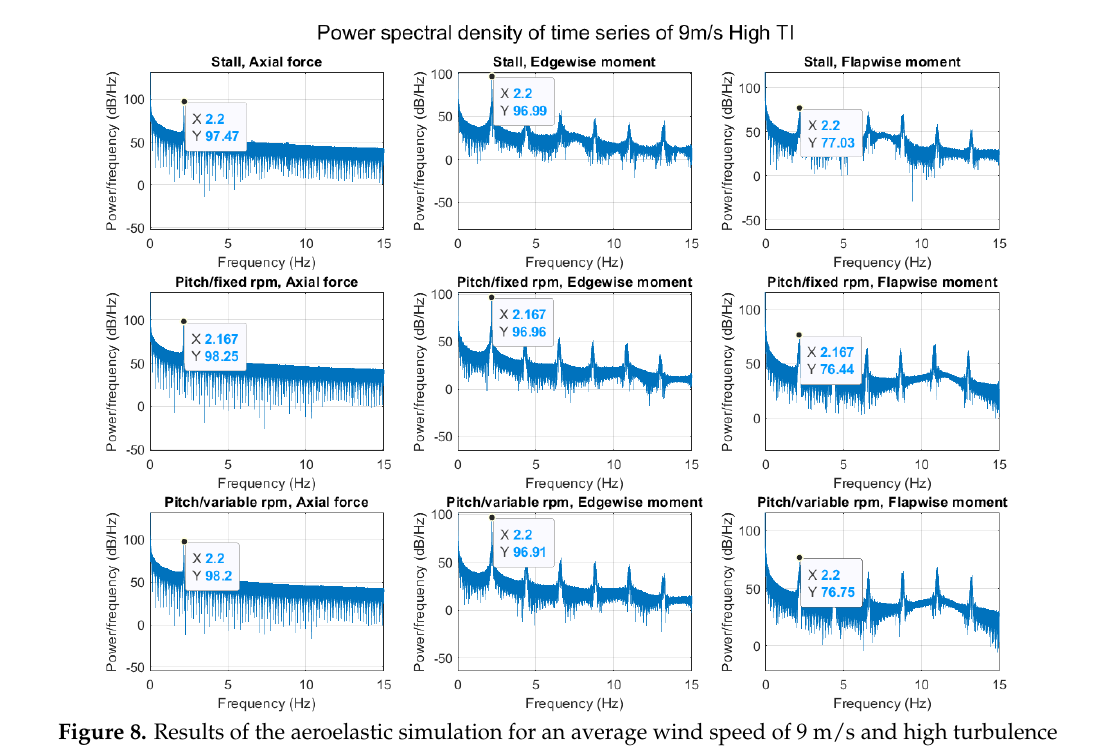
Figure 8. Results of the aeroelastic simulation for an average wind speed of 9 m/s and high turbulence intensity: power spectra.